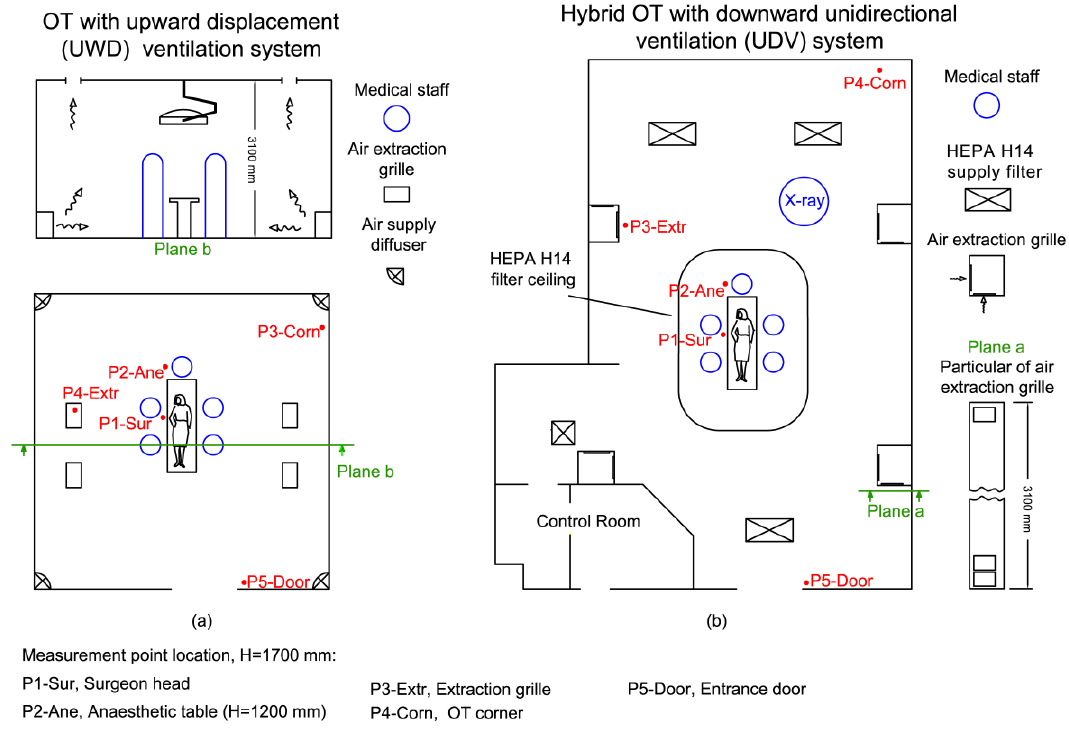
Figure 1. Operating theatres and sampling probe layout position: ( a ) OT with upward displacement airflow (UWD) ventilation system; ( b ) Hybrid OT with unidirectional downward airflow (UDV) ventilation system.